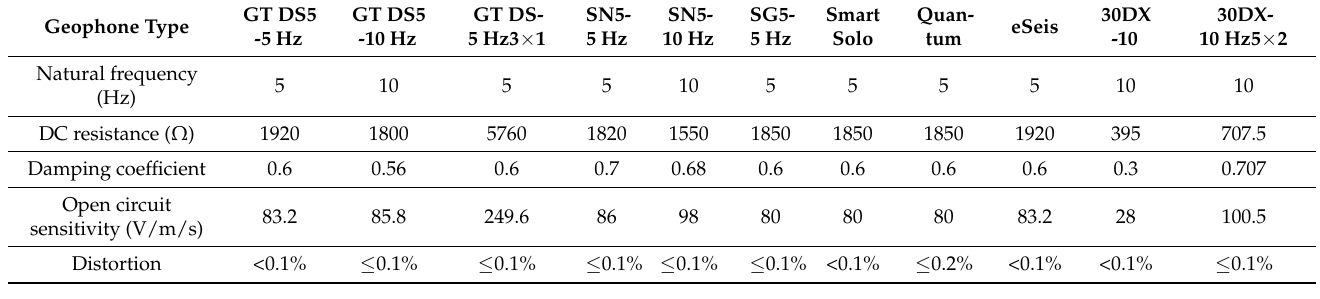
Table 1. Main technical parameters of commonly used geophones (including nodes).